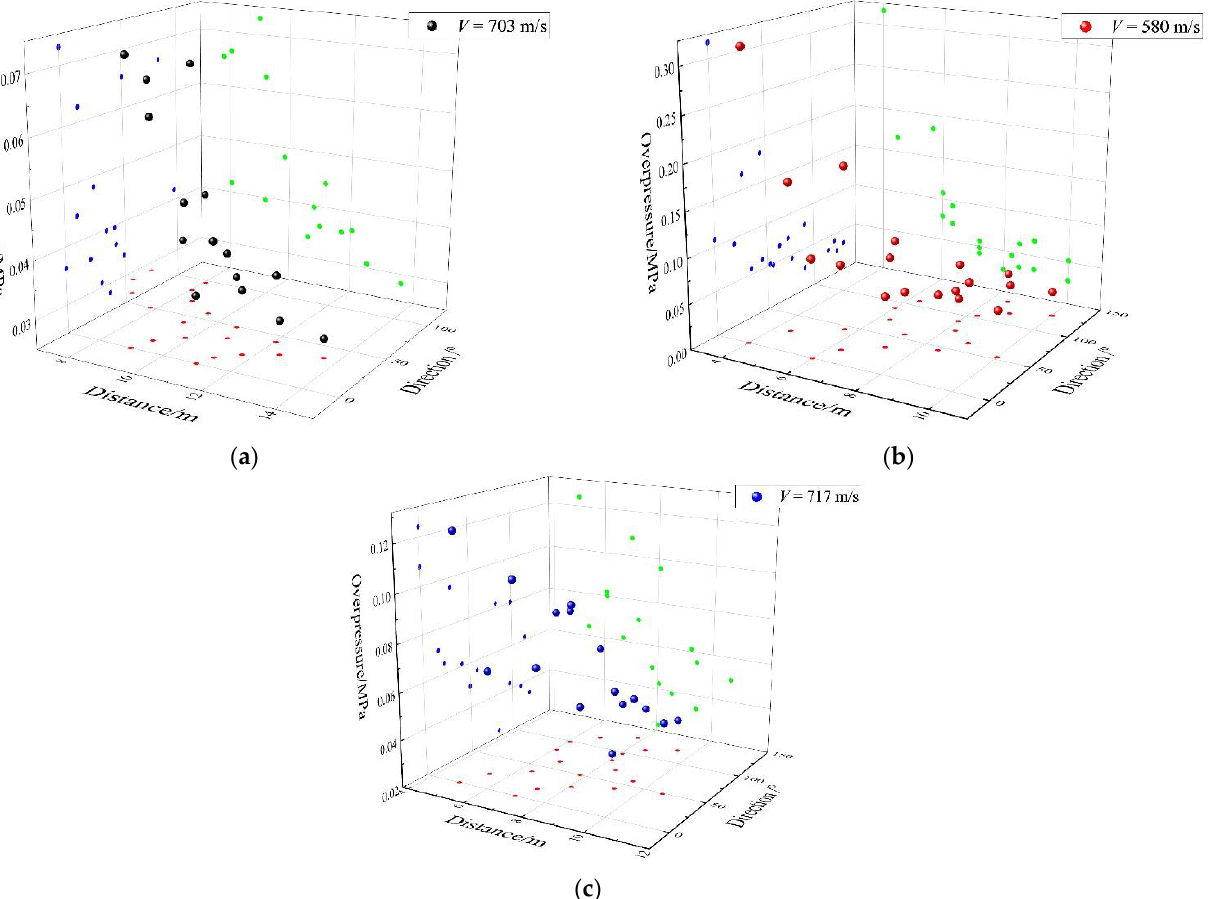
Figure 6. Distribution of the shock wave overpressure from moving charge explosions: ( a ) the speed was 703 m/s and the deviation was −3 m (in the opposite direction of the charge motion), ( b ) the speed was 580 m/s and the deviation was +2 m (in the positive direction of the charge motion) and ( c ) the speed was 717 m/s and the deviation was +1 m.